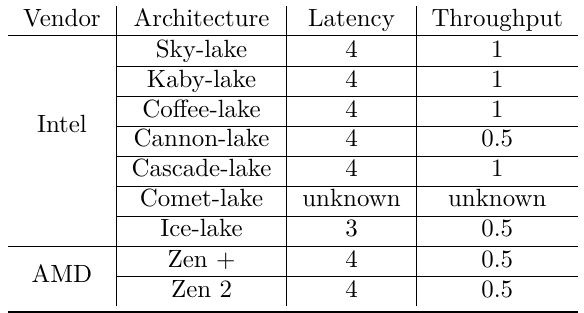
Table 1: Latency and throughput of aesenc for some architectures by Intel and AMD referred by